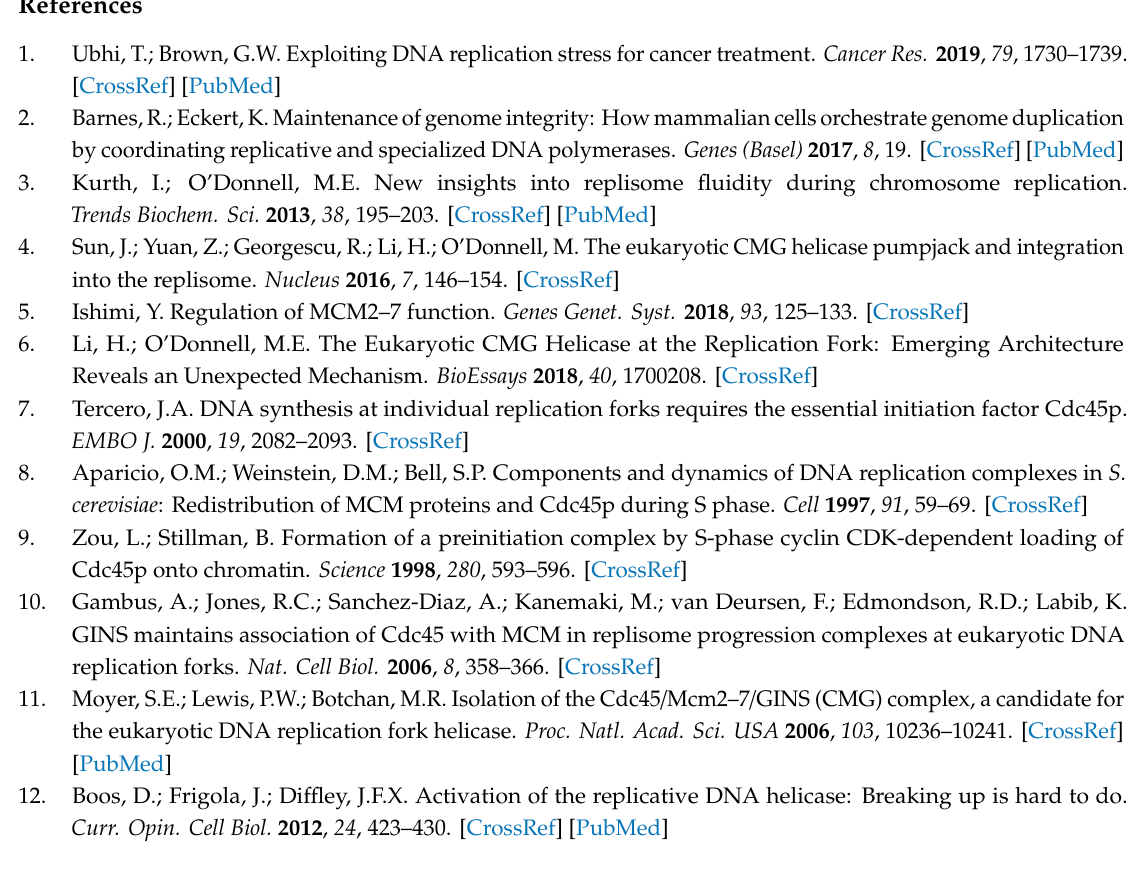
Figure 5 and Table S7; Table S9: Statistical analysis of results presented in Figure 6; Table S10: Yeast strains used in this study; Table S11. Primers used in this